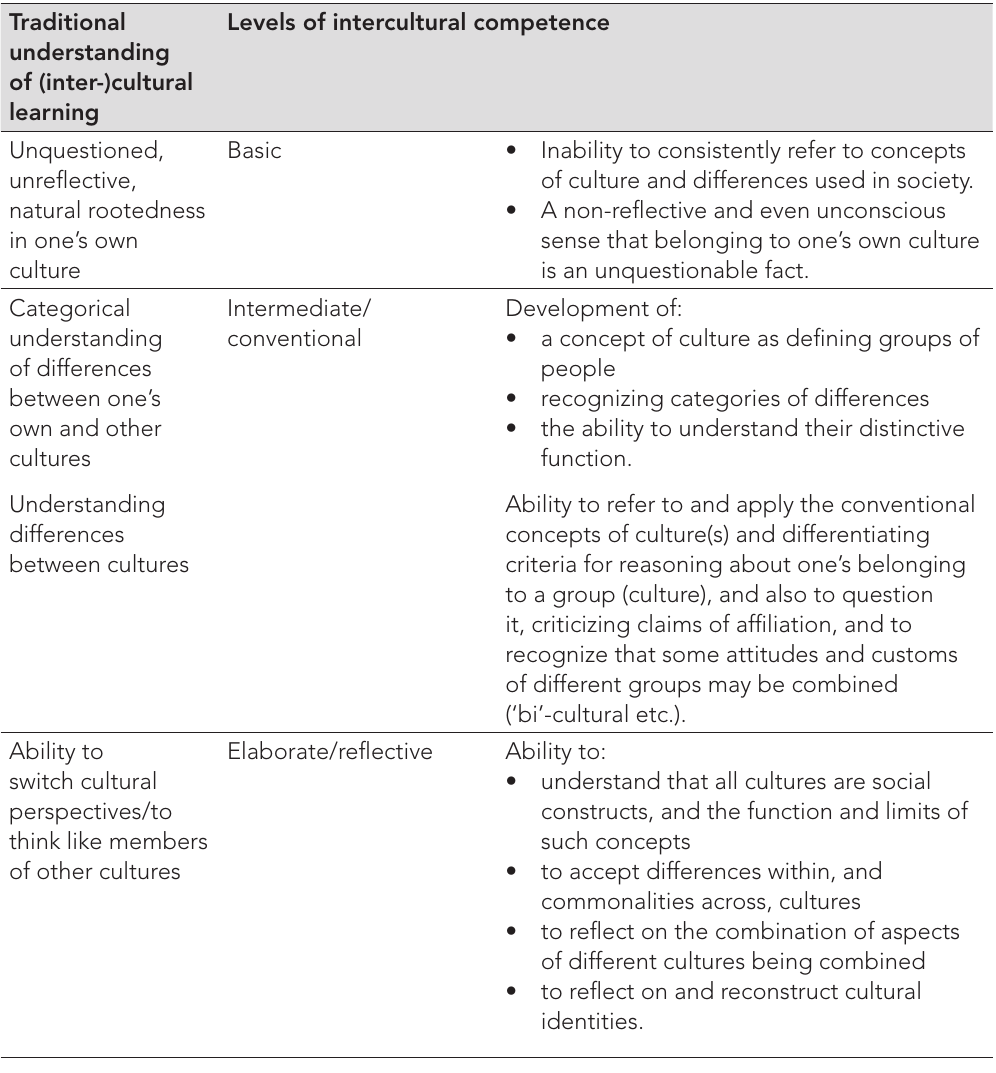
Table 1: Levels of intercultural historical